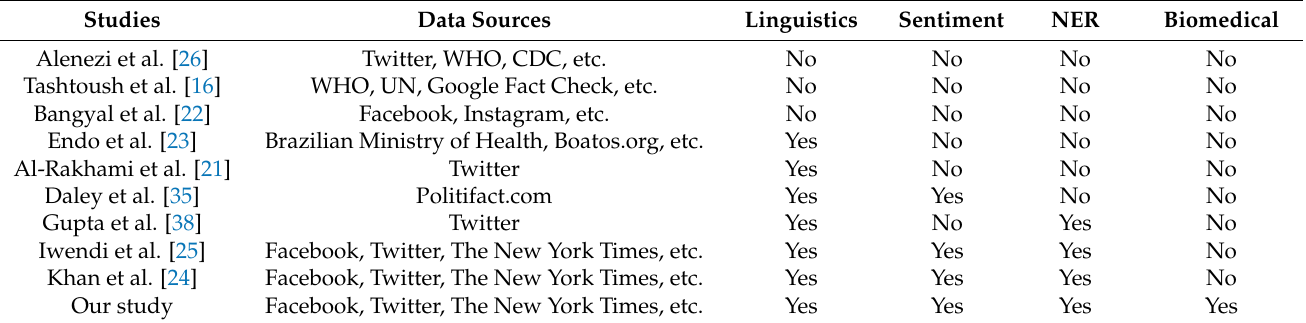
Table 1. Comparison of features used for COVID-19 fake news detection in different studies. Data